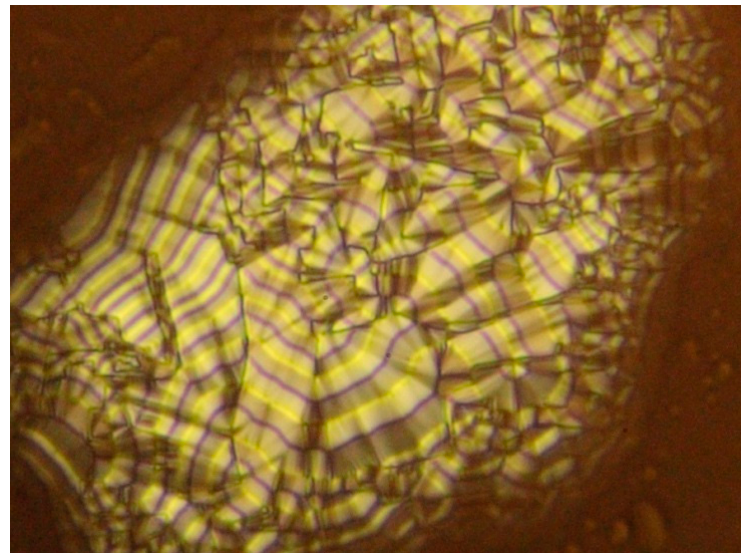
Figure 4. Planar texture of LJ10/10 in the B 1Rev phase at T = 100 °C: ( a ) before and ( b ) after the application of the electric field of about 20 V/m. The width of each figure corresponds to about 300 m.